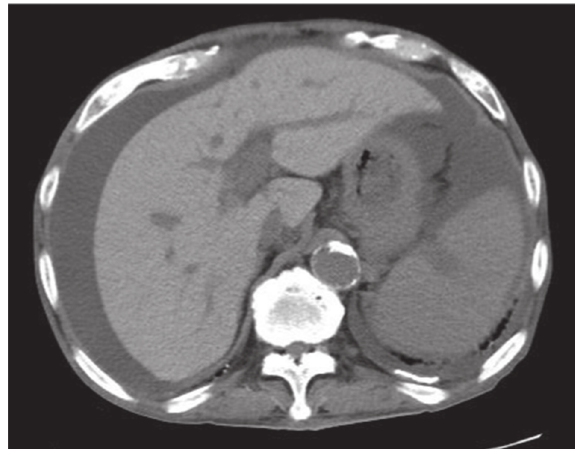
Figure 4: Image of plain computed tomography. Massive ascites and increased liver